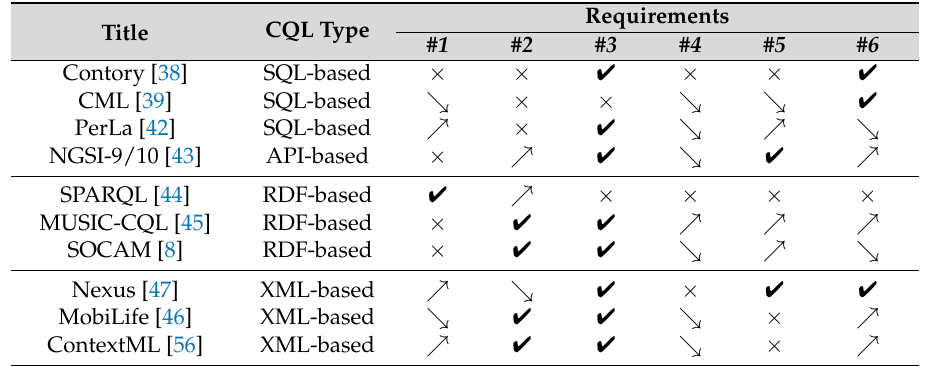
Table 1. Evaluation of Existing